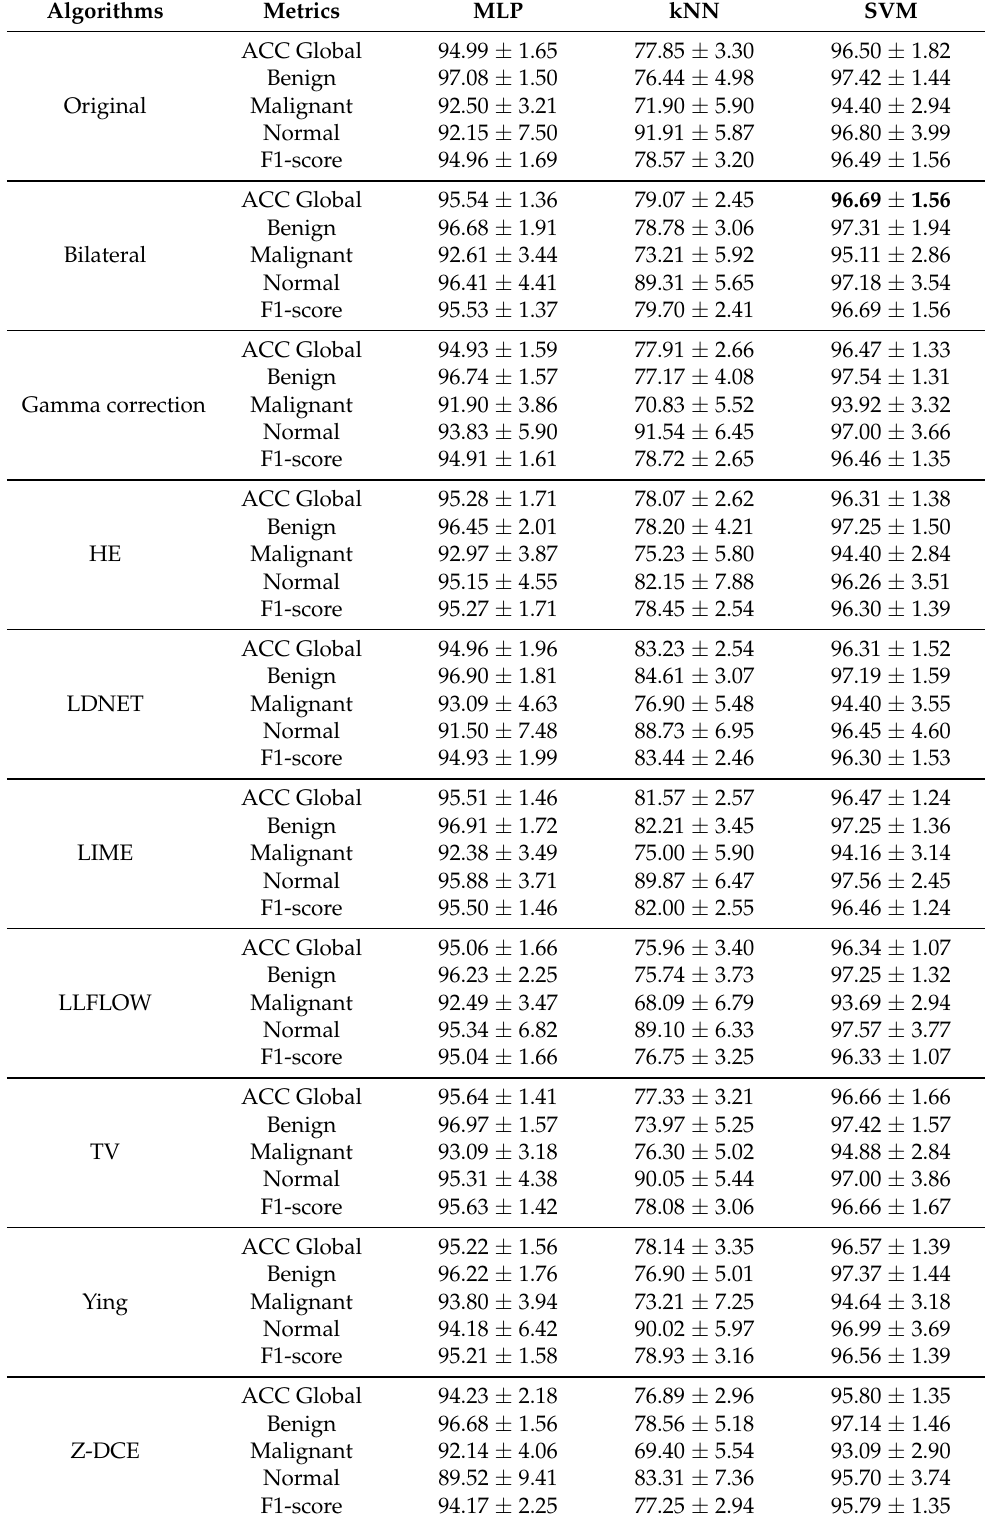
Table 5. Metrics for image enhancement